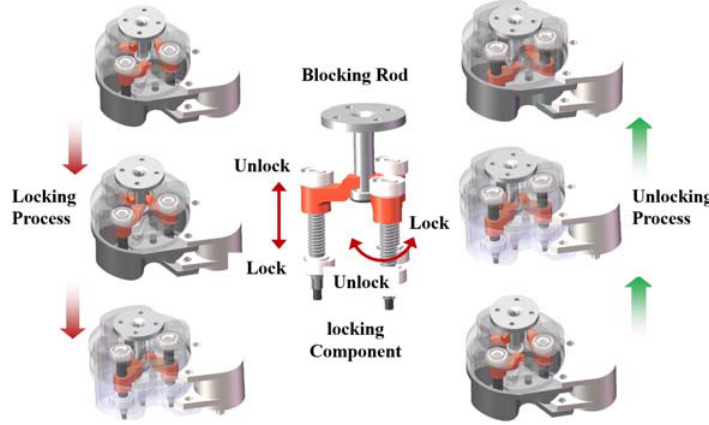
Figure 4. The locking process of the ORU locking module.